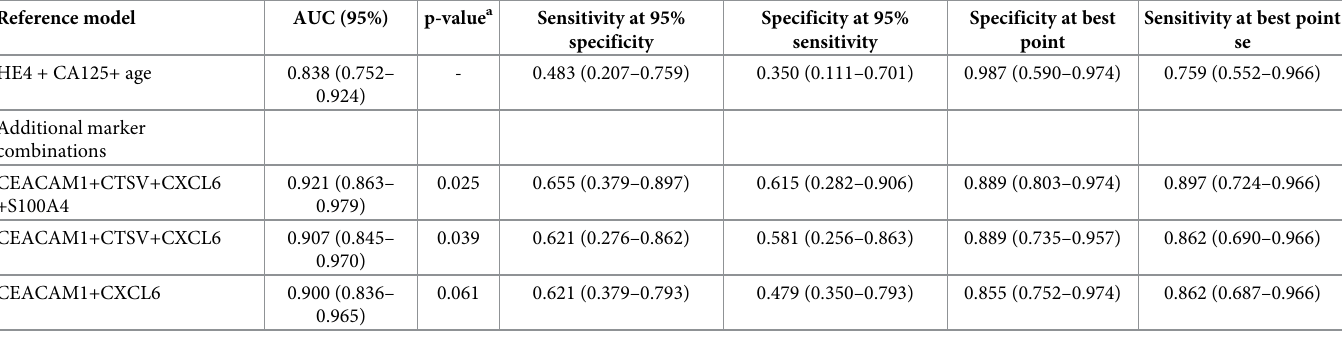
Table 5. Biomarker models, LASSO regression. Benign tumors vs. cancer.